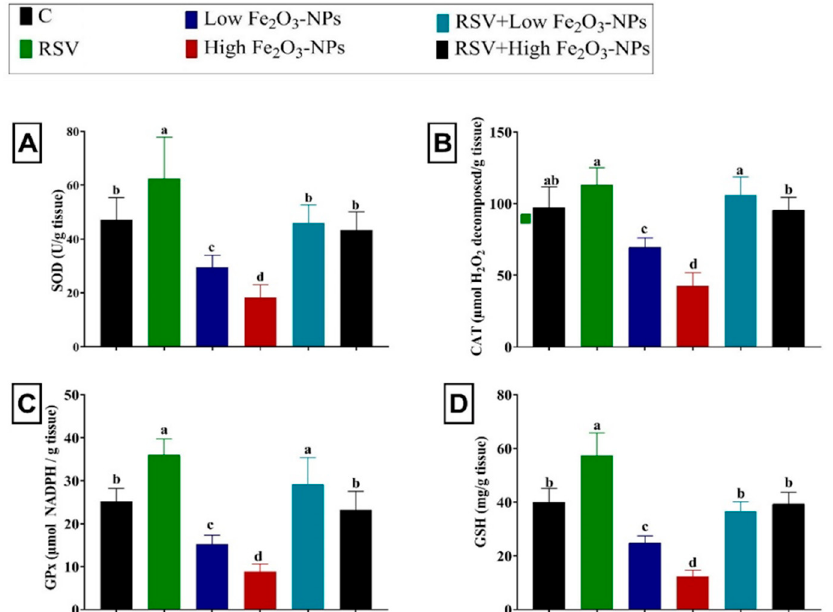
Figure 4. Effect of resveratrol (RSV; 20 mg/kg b.wt) and/or iron oxide nanoparticles (Fe 2 O 3 -NPs 3.5 or 7 mg/kg b.wt) administration for eight weeks on superoxide dismutase (SOD) ( A ) catalase (CAT) ( B ), glutathione peroxidase (GPx) ( C ), and reduced glutathione (GSH) ( D ) levels in the testicular tissues of male rats. Data expressed as mean ± SD, n = 9 for each group. Different letters (a, b, c, and d) on columns indicate statistically significant differences at p < 0.05 between the different experimental groups.